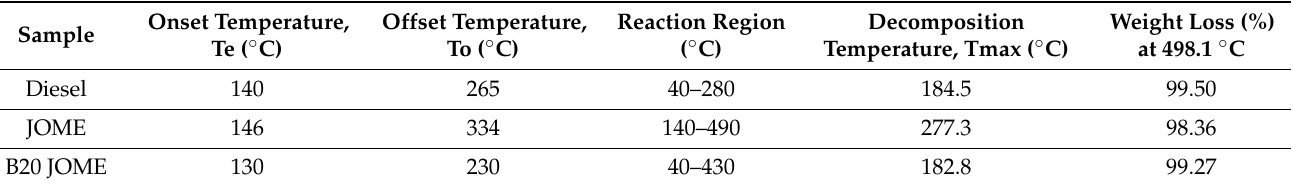
Table 5. Onset, offset, reaction region, maximum temperature, and weight loss biodiesels.